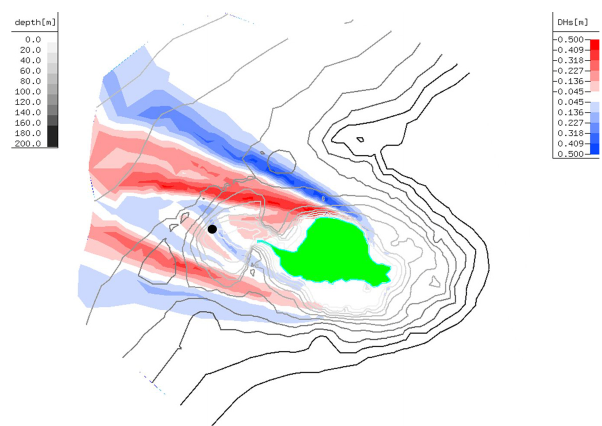
Fig. 11. Difference plot using phase decoupled diffraction. Red colour: enhancement of wave energy due to diffraction. Blue colour: reduction of wave energy due to diffraction (black dot indicates the position of the wave